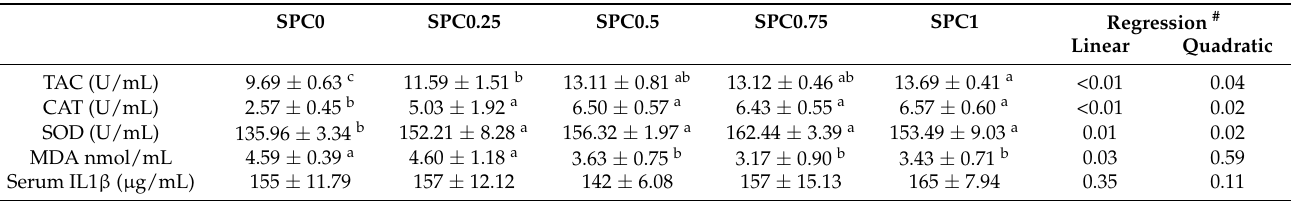
Table 5. Effect of dietary Spirulina platensis phycocyanin (SPC) addition on serum antioxidant and inflammatory